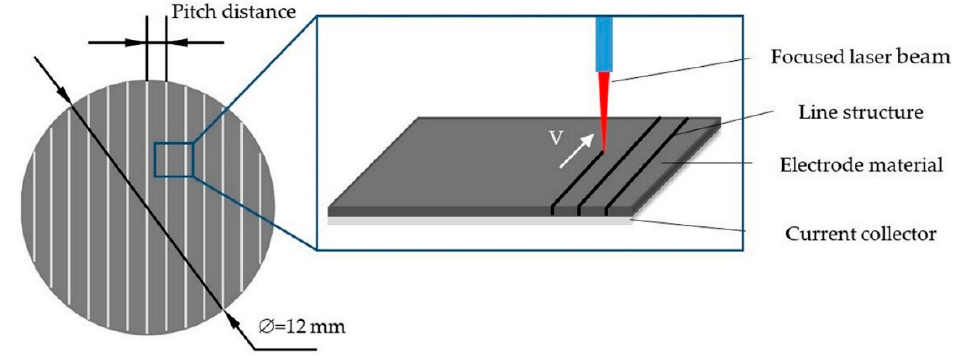
Figure 1. Schematic view of electrode design and laser structuring process.